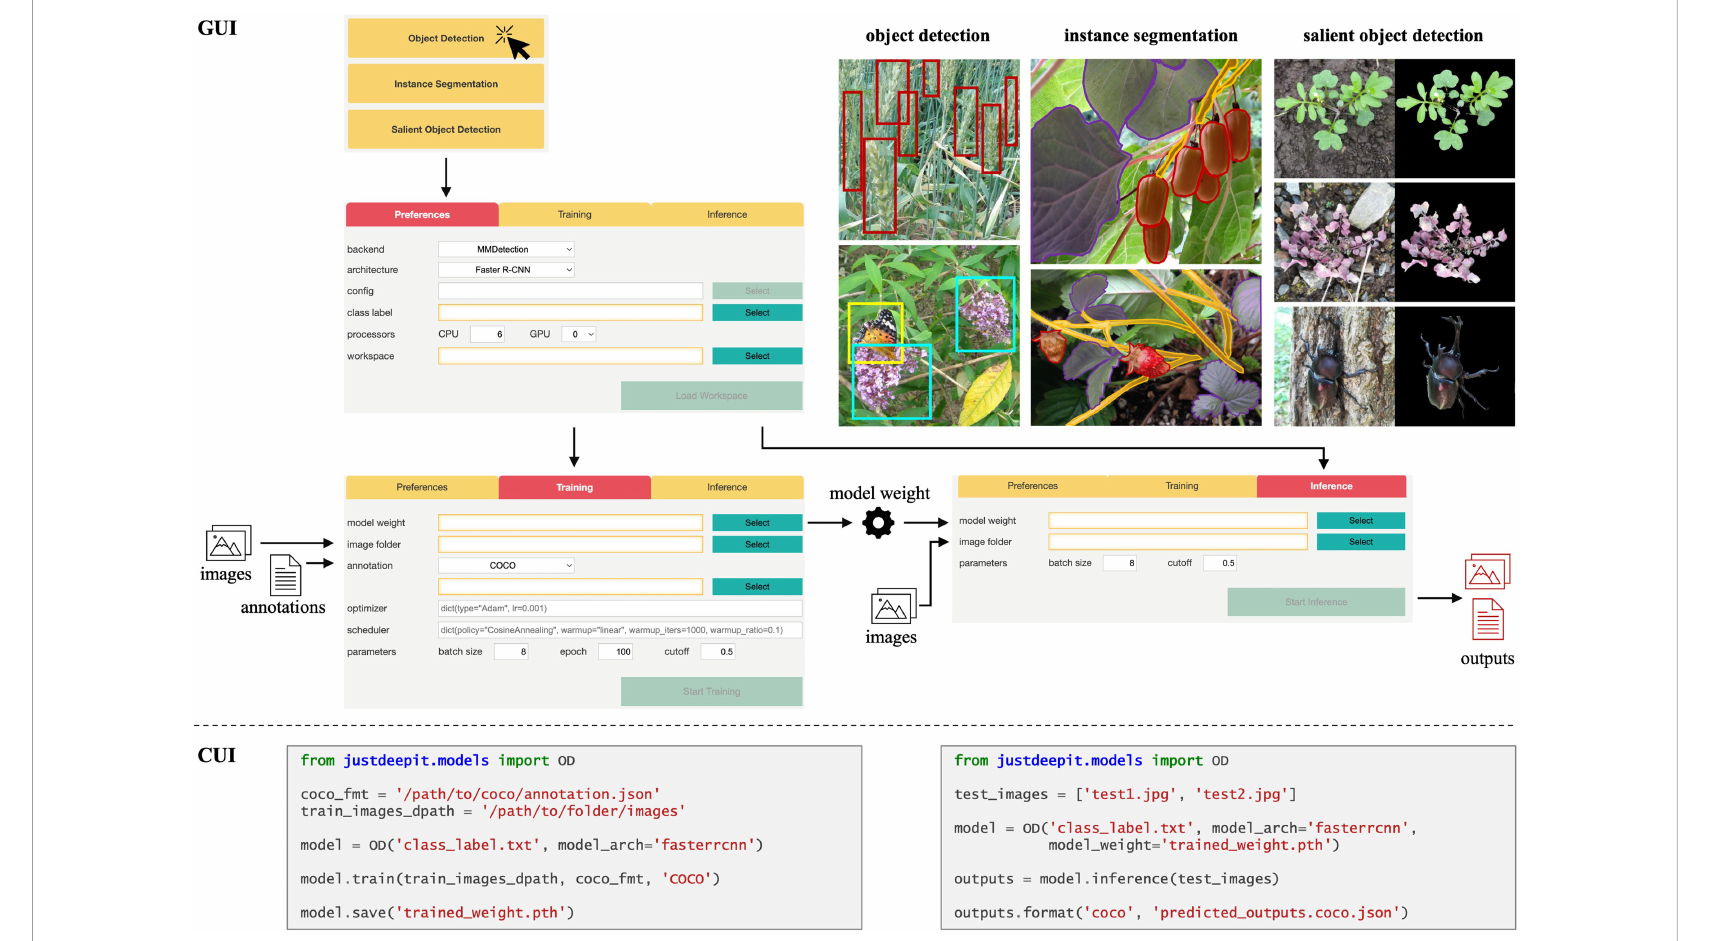
FIGURE 1 Overview of GUI and CUI implementation of JustDeepIt. For GUI usage, four main screens are implemented to select the analysis task, set standard parameters (e.g., neural network architecture, temporary folder), train a model, and infer new images with the trained model, respectively. For CUI usage, import the modules based on analysis tasks and then use the initialization method (e.g., OD ), train, save, and inference methods to set up a model, train the model, save the model, and infer new images with the trained model,